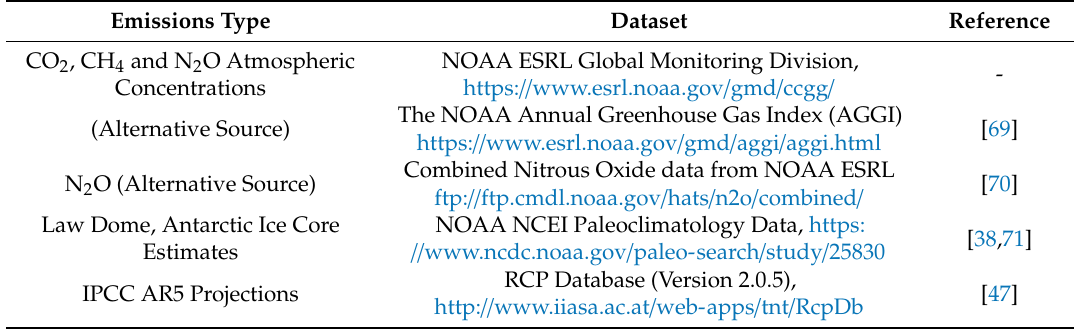
Table 4. Sources for atmospheric greenhouse gas concentration data used in this